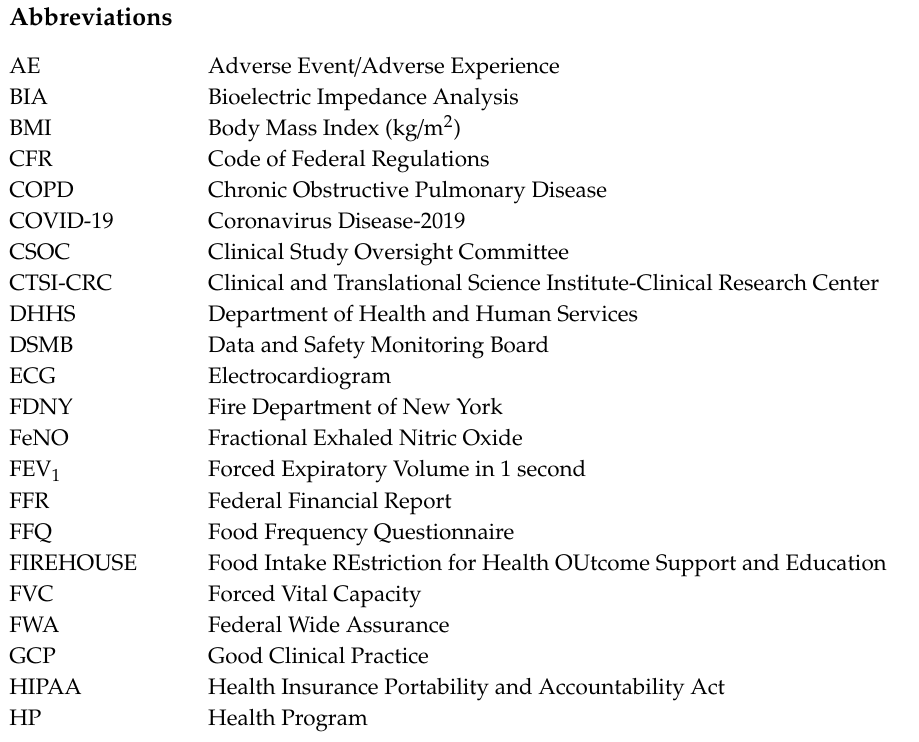
Figure S1: Interim Monitoring Bounds. Interpolated stopping boundaries—z-score critical values for the 3-look design. Table S1: Study